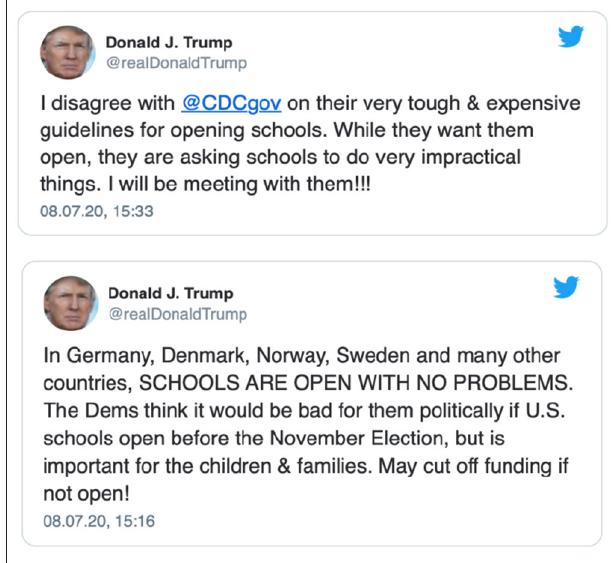
FIGURE 1 | Tweets of the U.S. President related to the CDC guidelines on reopening schools